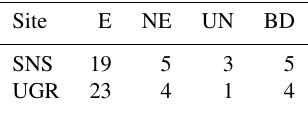
Table 2. Number of event (E), non-event (NE), or undefined (UN) NPF days and bad data (BD) observed at SNS and